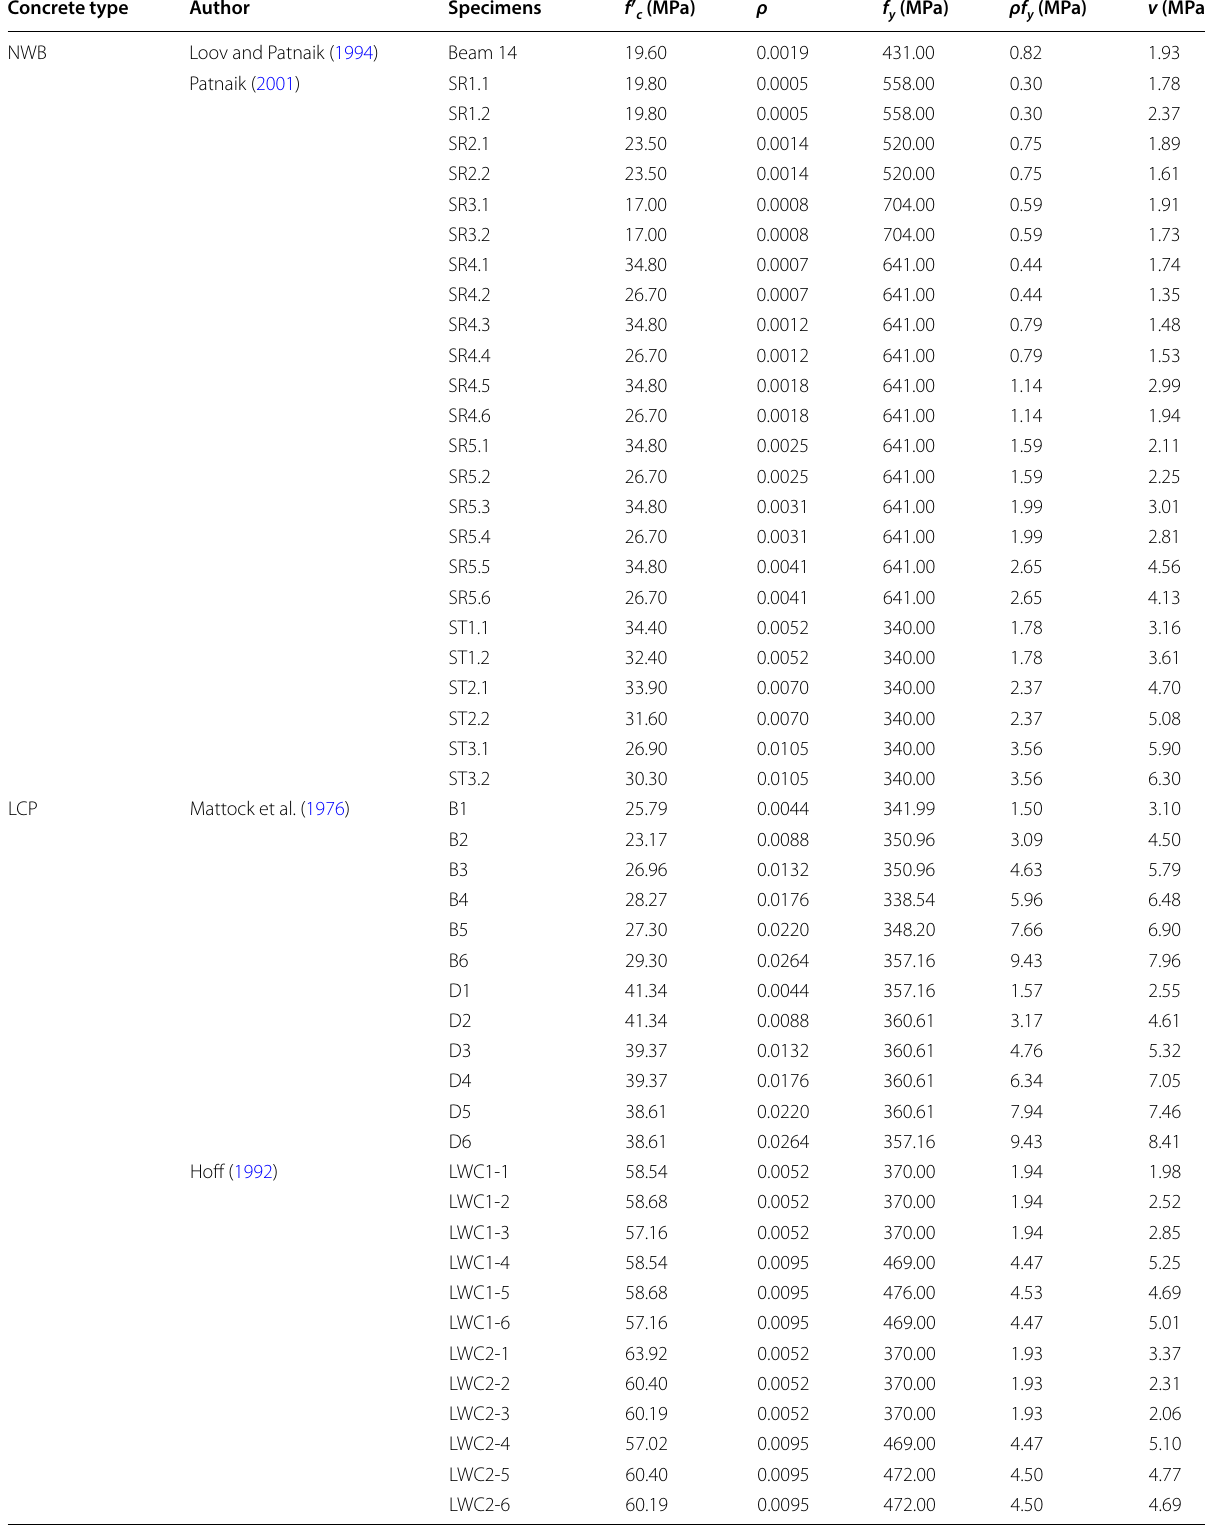
Table 9 Experimental results of other researchers’ with smooth interface